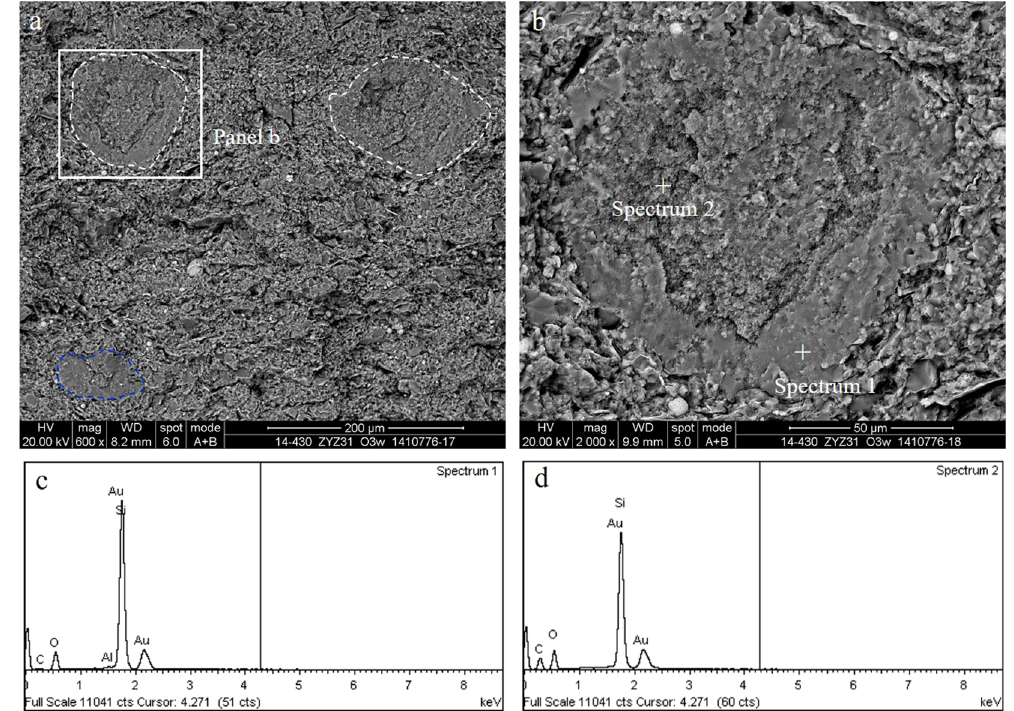
Figure 3. Multicellular algae from black shale in the Wufeng Formation in well Jiaoye 1 (2415.19 m). ( a ) Overview of the profile showing abundant multicellular algae. The sizes of individual algae range from tens of microns to more than 100 microns (white and blue dotted circle in the picture). Some multicellular algae may have been deformed by intense compaction (such as blue dotted circle in the picture). The multicellular algae may be the red algae cystocarp. ( b ) Multicellular algae with ring structure show inherent variation in its internal structure. ( c , d ) The energy spectrum of the diatom in ( b ).